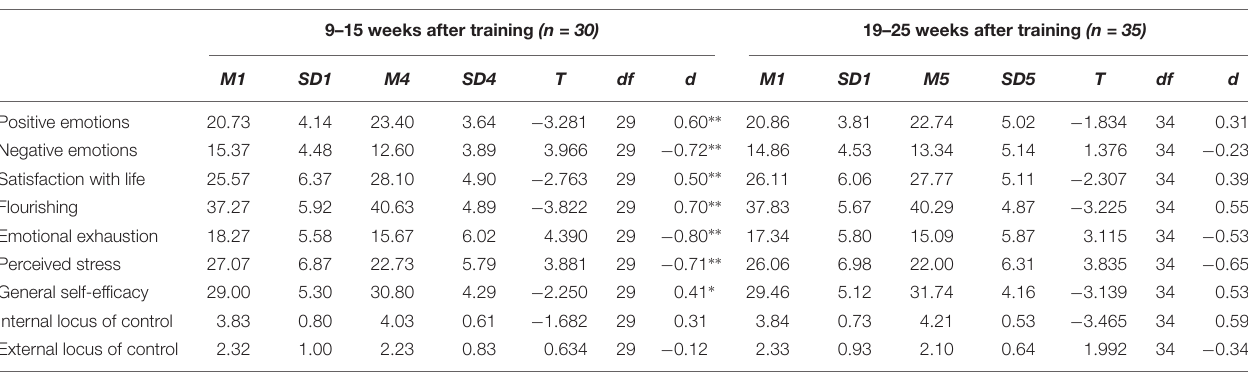
TABLE 7 | Long-term changes in the training group – without control